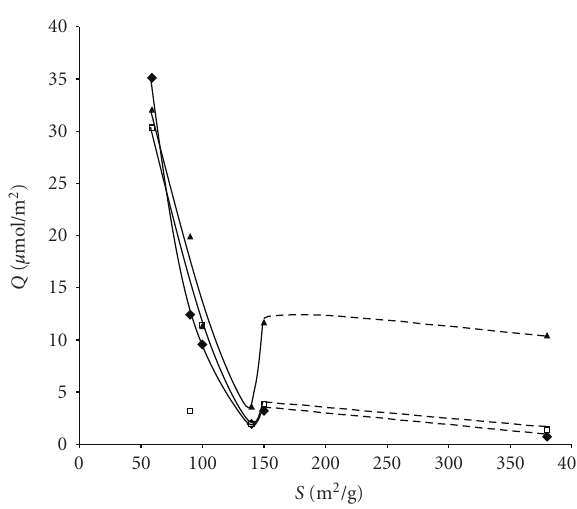
Figure 5: Content of adsorption centers with p K a 0.8 ( ) and 12.8 ( ) on the surface of the studied samples as a function of their specific surface area.